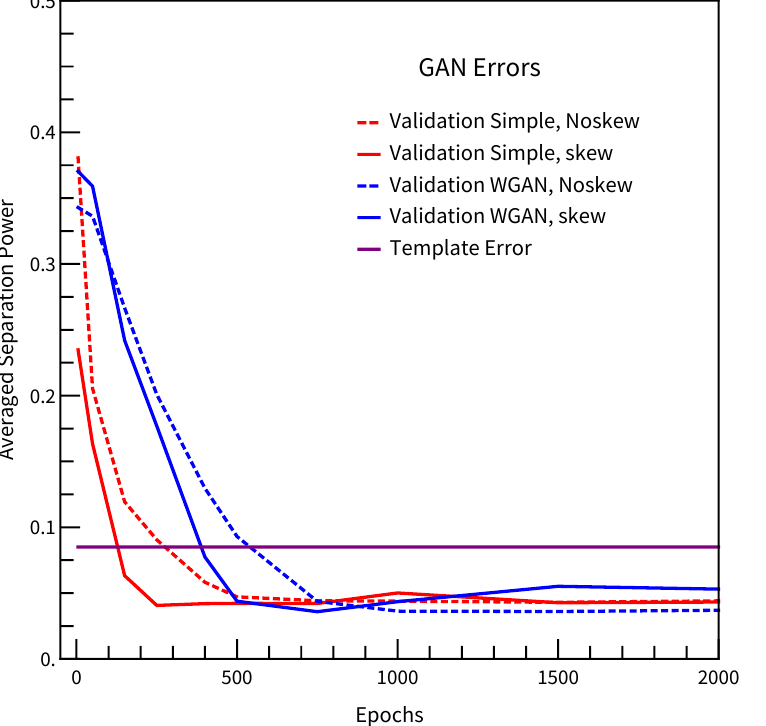
Figure 4 . Estimated separation power between the generated jet-kinematic distribution and the real jet-kinematic distribution for various GAN architectures. The template error corresponds to the baseline approach with no neural networks and is thus independent of the number of training